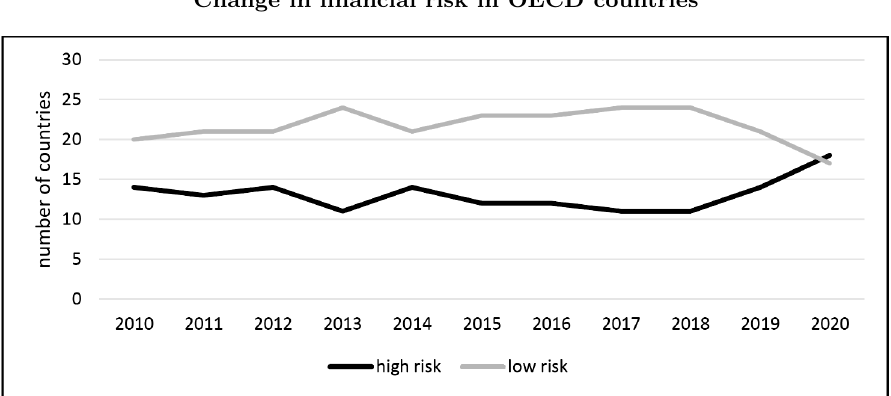
Source: Own study based on the IMF data, Government Finance